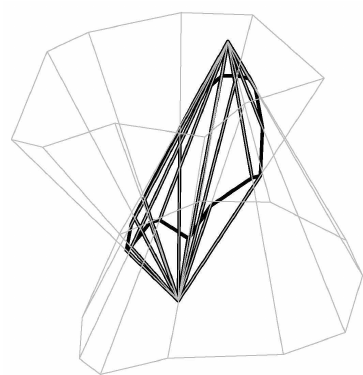
Figure 3. The construction of a network-based space-time